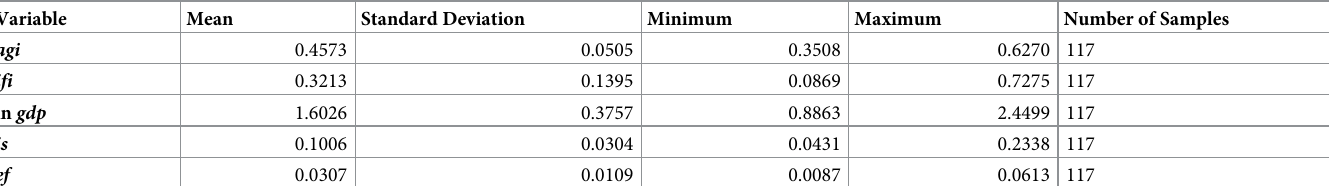
Table 5. Descriptive statistics of